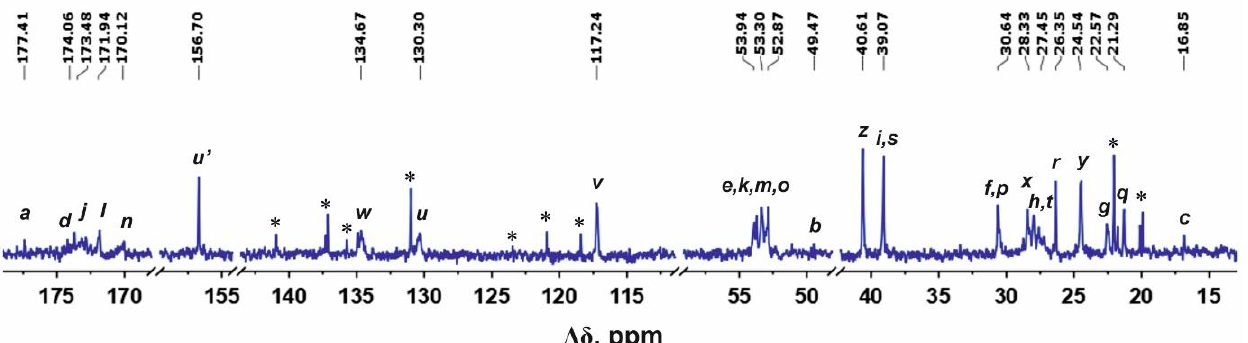
Figure 2. 13 C NMR spectrum of the Lys-Arg-His dendrimer at 298 K. The peaks from small molecular weight impurities are marked by asterix (*).